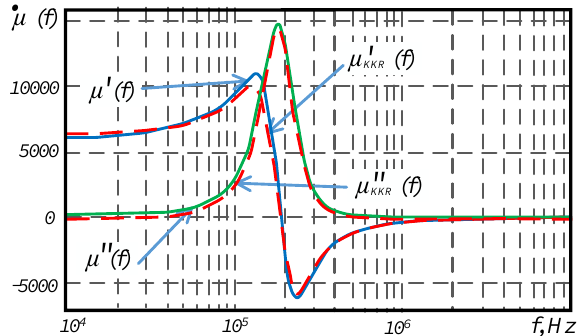
Fig. 3. KKR application to MnZn TDK-37 ferrite sample with dimensional resonance [13].